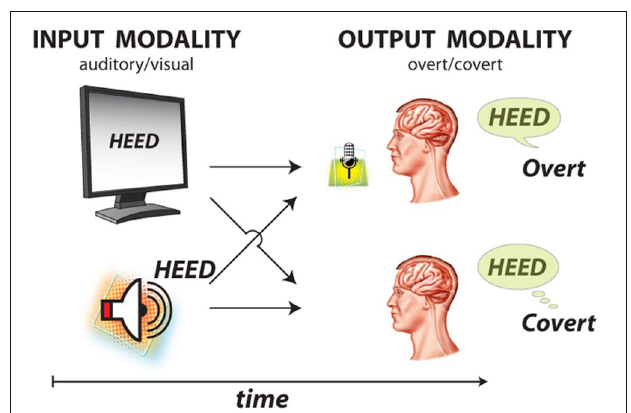
FIGURE 3 | Experimental paradigm with four conditions. Subjects were presented with 1 of 36 words using two sensory/input odalities: visual and auditory stimulus presentation. Subjects were asked to respond using two output modalities: overt and covert word